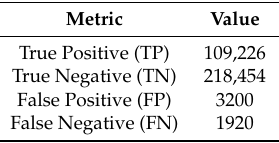
Table 2. Contingency table for the segmentation of the panels